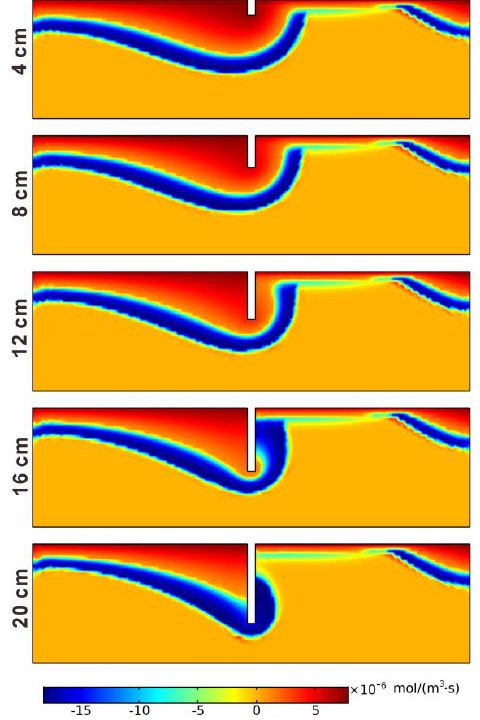
Figure 10. The reaction rates of net denitrification for different burial depths.